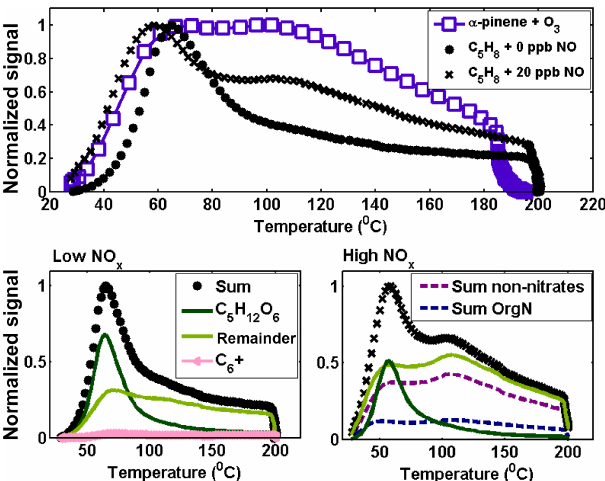
Figure 7. Top: sum thermograms of α -pinene + O 3 compared to isoprene (C 5 H 8 ) photooxidation with and without NO x . The α - pinene sum thermogram was reported previously (Lopez-Hilfiker et al. (2015), Fig. 5). Bottom: the sum thermograms at low (left) and high (right) input NO. The thermogram of C 5 H 12 O 6 , the largest signal in both cases, is separated out (dark green) and the sum of the remaining signal minus C 5 H 12 O 6 is displayed as the remaining signal (light green). At low-NO input, the sum of compounds with six or more carbons is specified (pink triangle and line), while at high-NO input the sum of OrgN and the sum of non-nitrate organ- ics are plotted (dashed lines, independent of solid lines) to show the relative thermogram